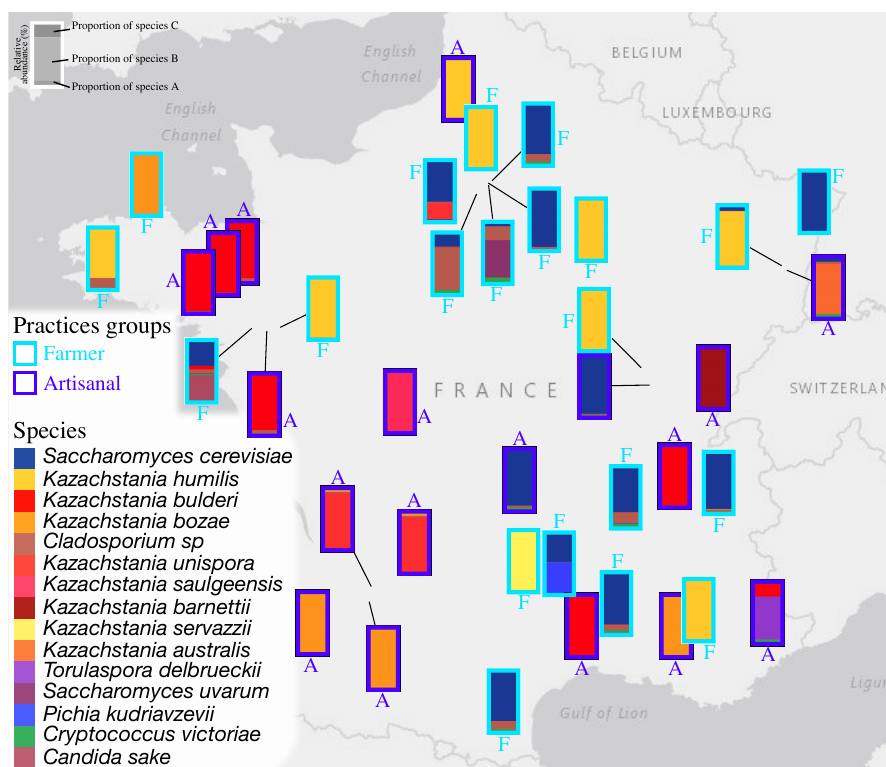
Figure 4: Fungal species composition of 38 French sourdoughs. Each bar represents one sourdough and is placed on the map where the sourdough was collected. Sourdoughs coming from bakers with a “farmer” practice are bordered in light blue and labelled with an “F” while sourdoughs coming from bakers with “artisanal” practice are bordered by dark blue and labelled with and “A”. Each species is represented by a different color. The relative abondance of each species, estimated by metabarcoding analysis, is represented by the area of each bar, as shown at the top